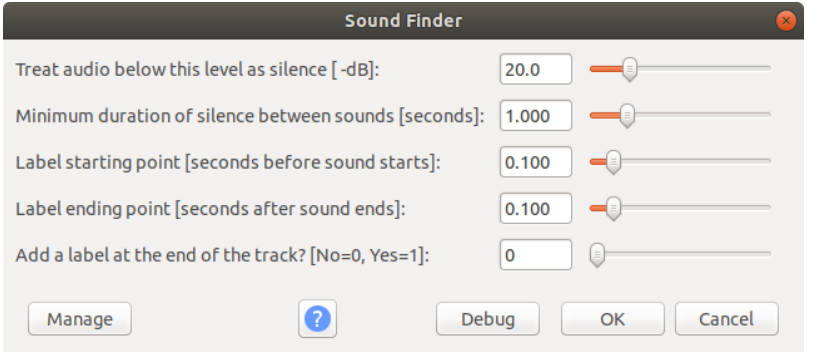
Figure 3. Parameters of the “Sound Finder” analysis